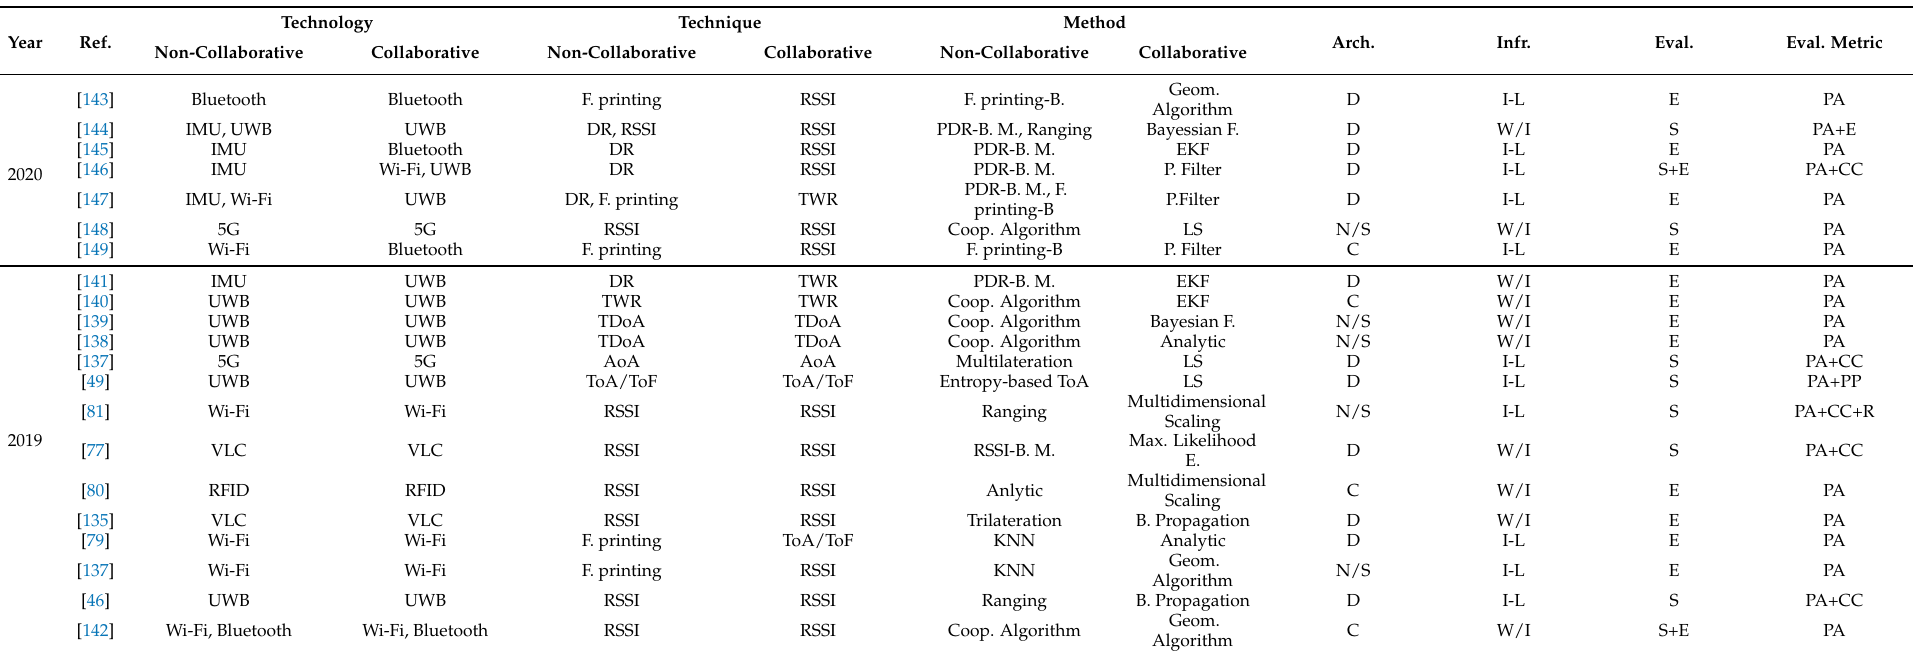
Coop. Algorithm Geom.